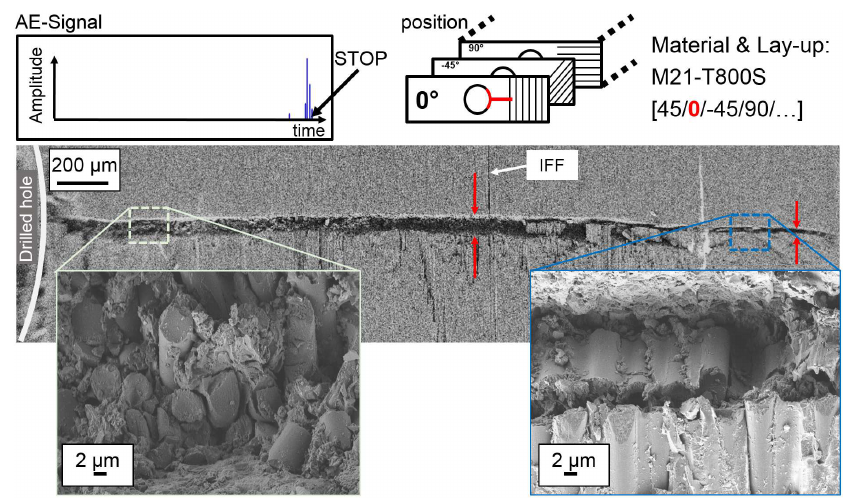
Figure 11. Damage propagation in the outer 0°-layer at the hole in a representative M21-T800S specimen.